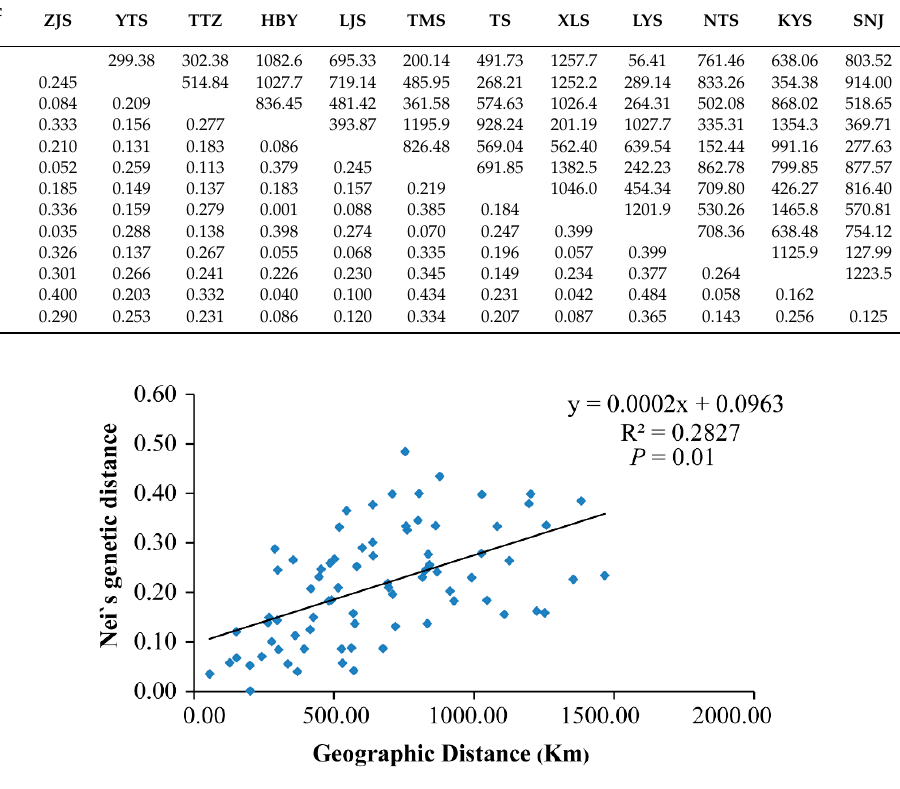
Table 2. Nei’s genetic distance (below diagonal) and geographic distance (above diagonal, km) between geographic populations of P. glacialis . Geographic